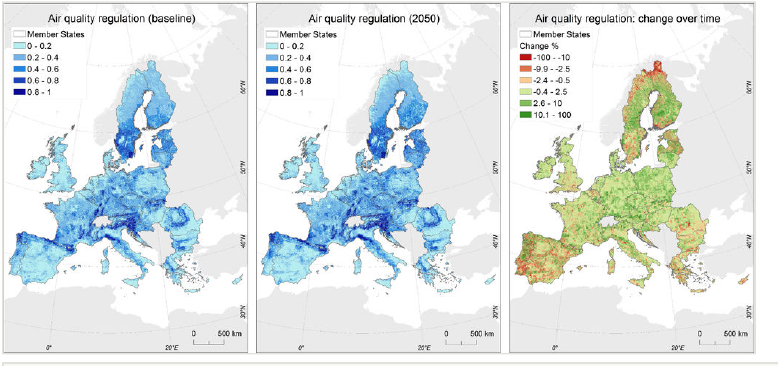
Figure 6. Air quality regulation for baseline, 2050 and as a percent change over time (2050 vs. baseline). For the baseline and the 2050 maps, classes represent equal intervals over the range of rendered predictions; for the percent change over time, the visual representation re fl ects the distribution of the values. Maps are displayed using the Projected Reference System LAEA. See main text for additional